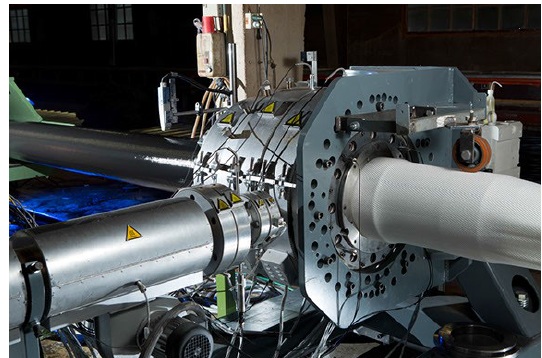
Figure 1: A picture from the extrusion process at Fen- ner Mandals